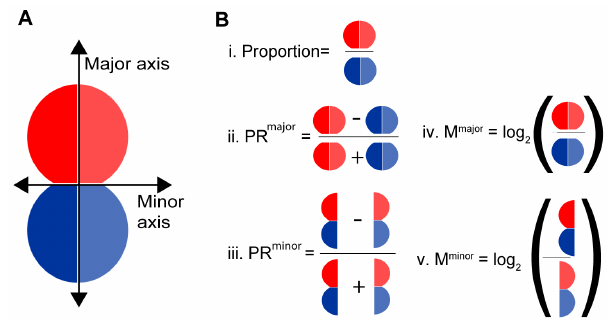
Figure 1. Axial subdivision for polarization analysis. ( A ) An approach for quantification of polarity. Black arrows represent the major and its perpendicular minor axis. Splitting the image into two allows a direct comparison of fluoresce intensity across the minor or major axes. The major axis is derived from the longest diameter of an ellipse that overlaps the cell. The minor axis is defined as the perpendicular to the major axis. Blue and red colors show the areas from which pixel intensities were collected, and represent the two halves of the cell that would, if the cell divided, become daughter 1 and 2. The left and right sides of the cells are bright and dim respectively. ( B ) Polarization ratios are extracted by integrating pixel intensities across the major or minor axis: i) Ratio along the major axis (using segments divided by the minor axis). ii) PR major : Normalized ratio along the major axis (across the minor axis). iii) PR minor : Normalized ratio along the minor axis (across the major axis).